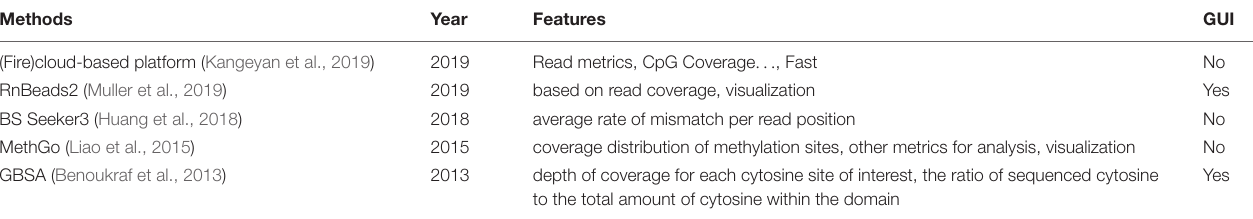
TABLE 2 | Quality control methods for bisulfite sequencing data.